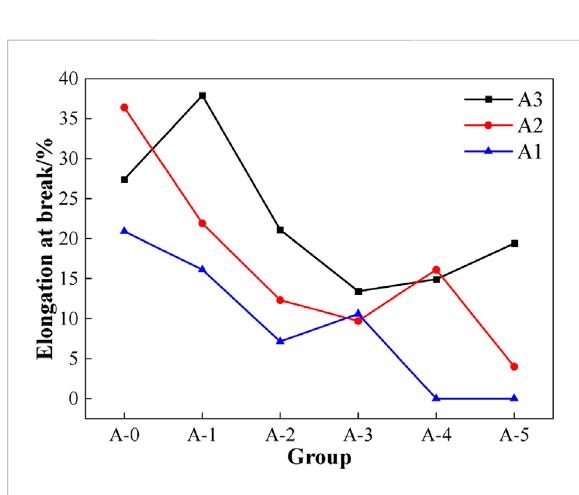
FIGURE 6 Effect of sodium alginate on elongation at break of microbial repair